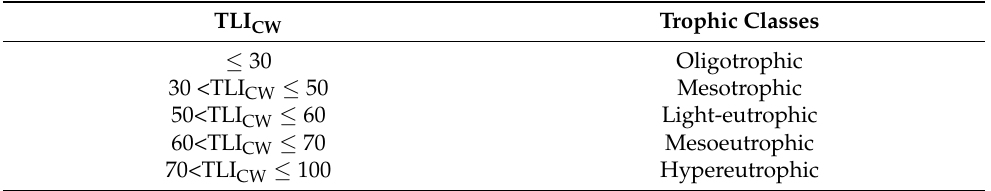
Table 1. Changed weight trophic level index (TLI CW ) eutrophication grading